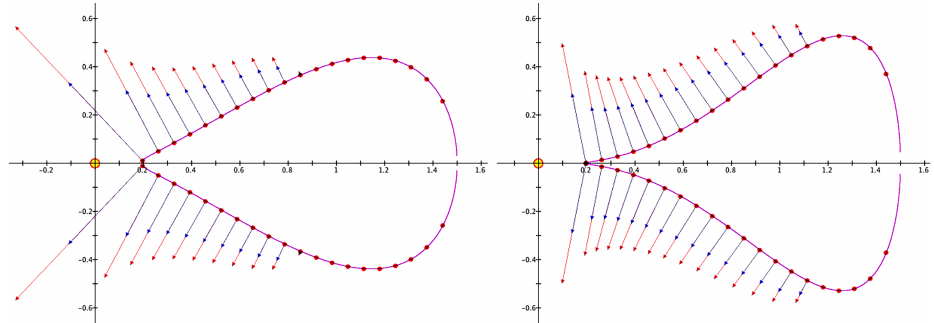
Figure 3. Ring model according to Equations (11) and (12) with r − = 0.2, r + = 1.5, b = 0.66, n = 1 ( left ) and n = 2 ( right ). The blue arrows show the velocity field, the red arrows show the velocities divided by the local sound speed as derived from the pressure in Equation (14) (Mach vectors).